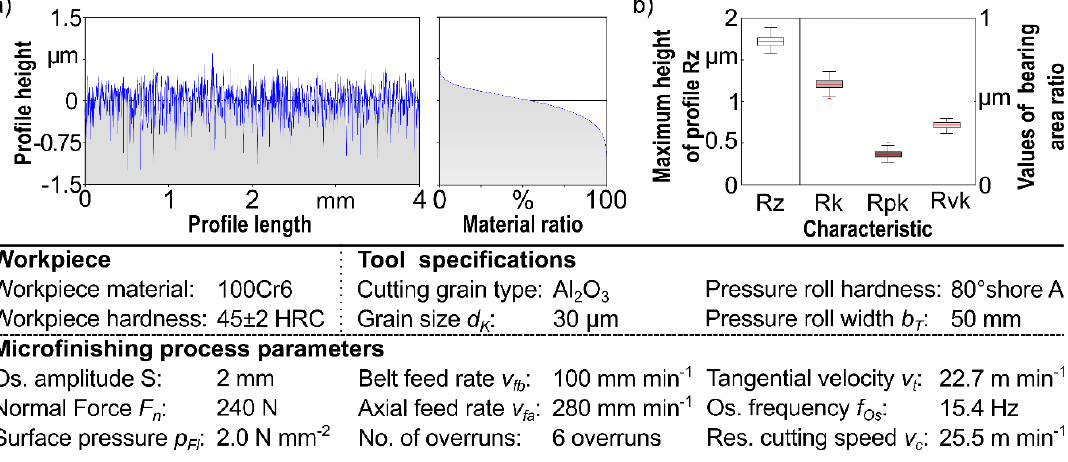
Figure 5. Resulting surface for the first fine microfinishing step by means of ( a ) the profile and material ratio curve and ( b ) surface values. ratio curve and ( b ) surface